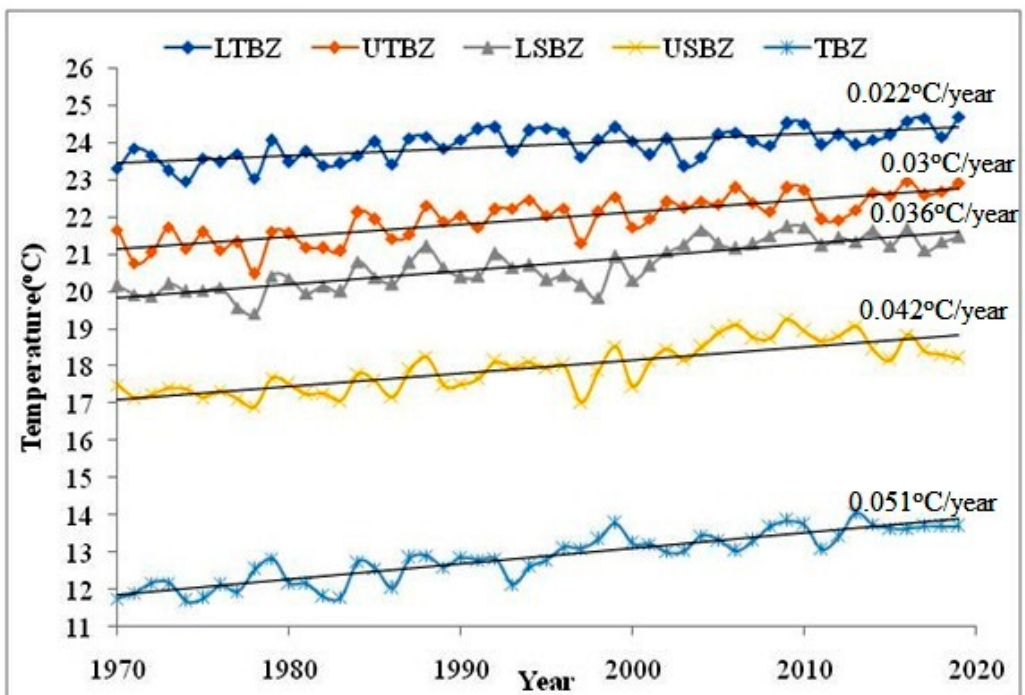
Figure 6. Average temperature trends in different bioclimatic zones of CHAL (1970–2019). Table 4. Increased average temperature (°C) per decade in different bioclimatic zones of CHAL since 1979 .